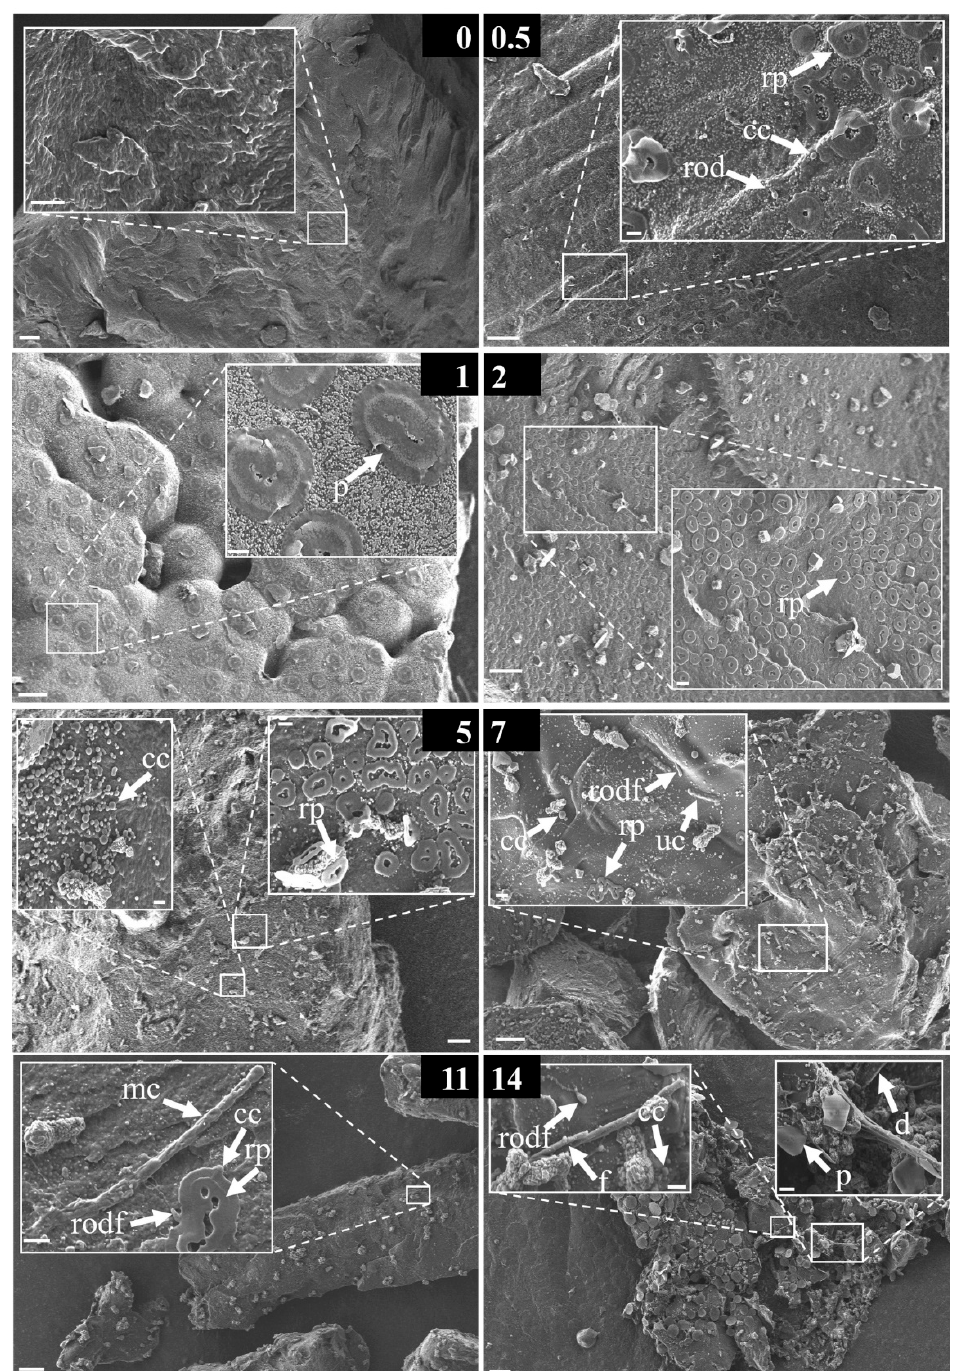
Figure 4. Scanning electron microscopy images of PA incubated in freshwater. Numbers in black boxes indicate incubation times in days (0 = raw material, 0.5 = half day, 1 = one day, 2 = two days, 5 = five days, 7 = seven days, 11 = eleven days, 14 = 14 days of incubation). Microorganismal structures are highlighted with arrows. rod = rod / vibrio-shaped bacteria, rodf = rod / vibrio-shaped bacteria with long flagella, cc = coccoid bacteria, d = diatom, f = filamentous structure, mc = multicellular structure, rp = round platelet structure, p = platelet structure, uc = unicellular structure. Scale bar: Large image 10 µm, magnified image 2 µm.